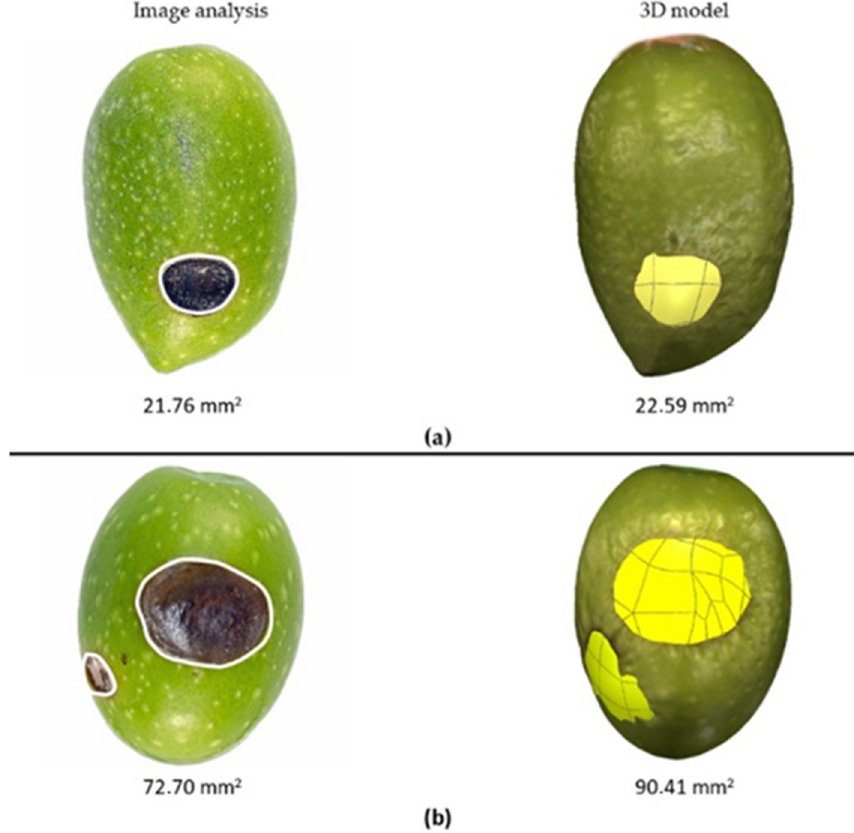
Figure 28. Bruise area calculated by image analysis vs. 3D analysis, with damages in the non-de- formed position ( a ) and in the deformed position ( b ) regarding the top horizontal plane.